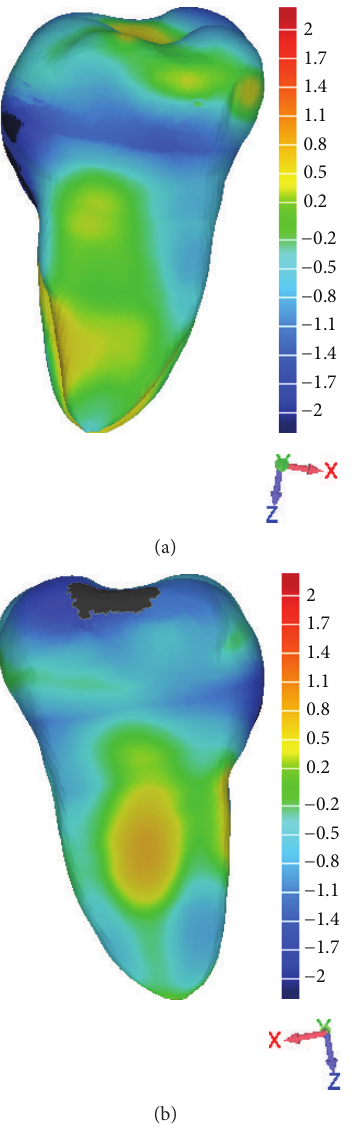
Figure 8: Superimposition and dimensional comparison between the dimensional parametric model and the segmented model of the mandibular molar from a distal view (a), and from a mesial view